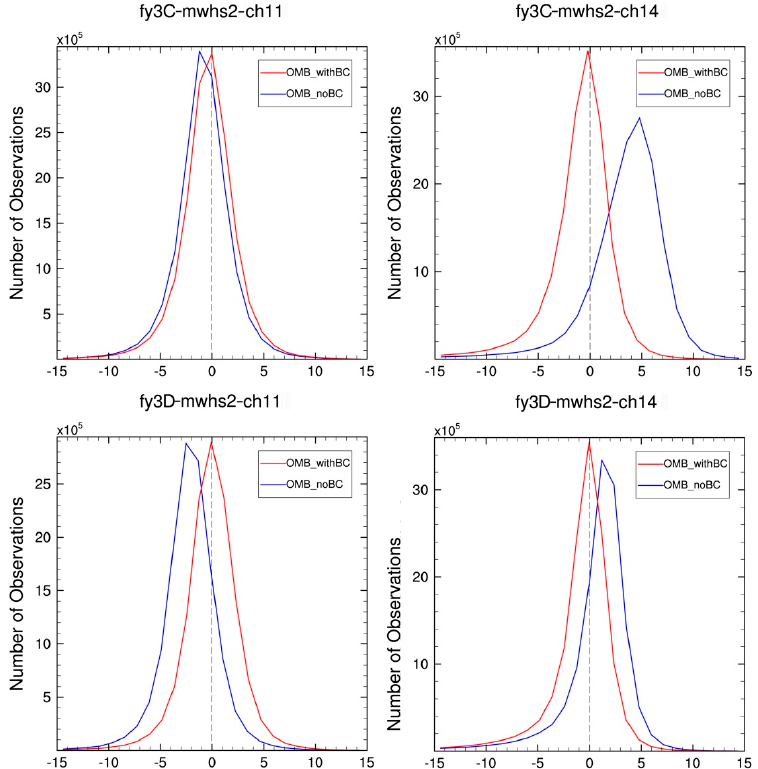
Figure 3. Histogram of the brightness temperature innovations distribution with (red) and without bias correction (blue) for MWHS-2 channels 11 and 14 from FY-3C and FY-3D, respectively.